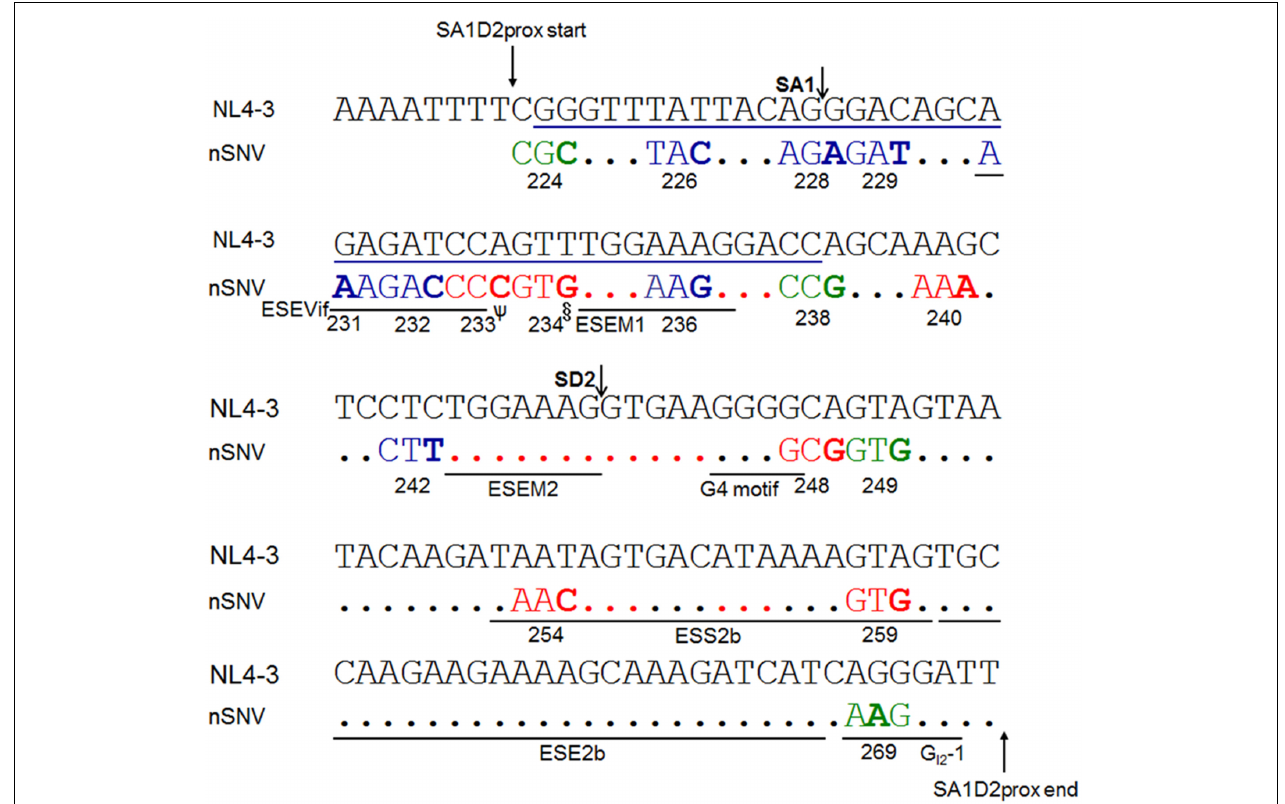
FIGURE 5 | Locations of nSNVs in SA1D2prox sequence (nucleotides 4899-5040 of HIV-1 NL4-3) that significantly alter vif expression level. Numbers below the sequences represent amino acid positions of HIV-1 NL4-3 Pol-integrase. SA1/SD2 sites and reported splicing regulatory elements (ESEVif, ESE-M1, ESE-M2, G4 motif, ESS2b, ESE2b, and G I2 -1 in Kammler et al., 2006; Exline et al., 2008; Mandal et al., 2009; Widera et al., 2013; Brillen et al., 2017) are shown. A blue line indicates the SLSA1 region. The nSNVs that significantly alter vif expression level are shown by colored and bold letters. Blue/red/green letters indicate low/high/excessive vif types (Nomaguchi et al., 2016), respectively. Red dots show the sites for which no proviral clones for analysis were constructed, because the sequences are highly conserved among HIV-1 subtype B strains. Black dots represent the sites for which proviral clones were constructed and analyzed, but nSNVs there were found to affect vif production only modestly. ψ , G, and T variants are also high vif type. §, C variant is also high vif type.